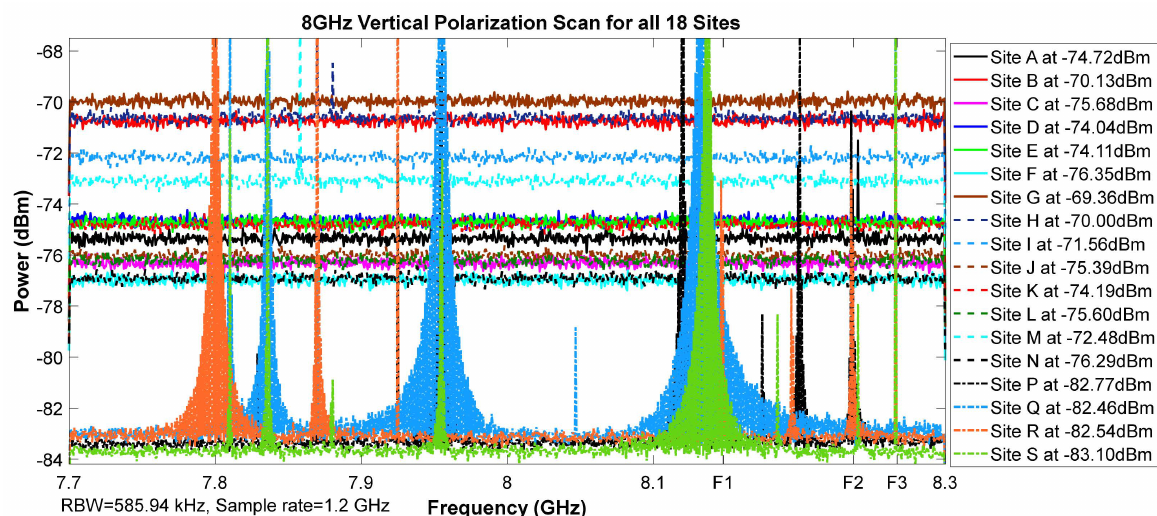
Figure 10. 8 GHz vertical polarization scan for all 18